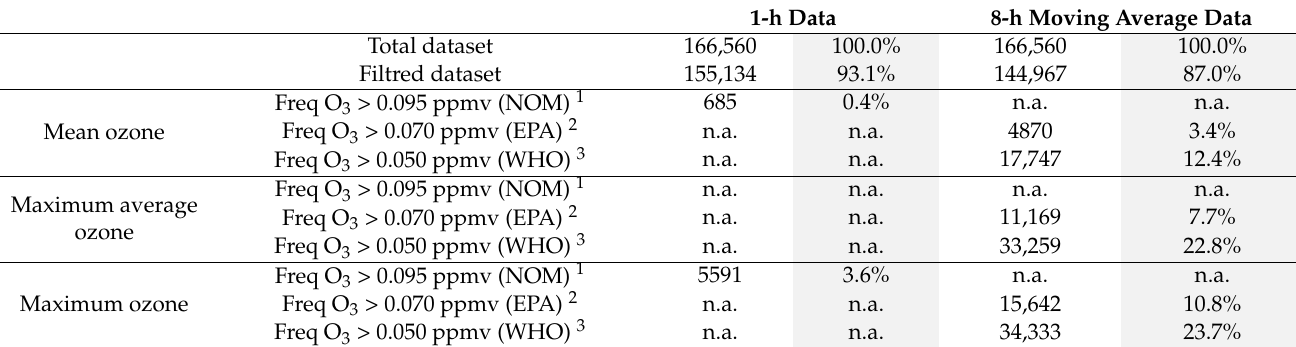
Table 2. Ozone frequency analysis based on the typical dataset (19 years).